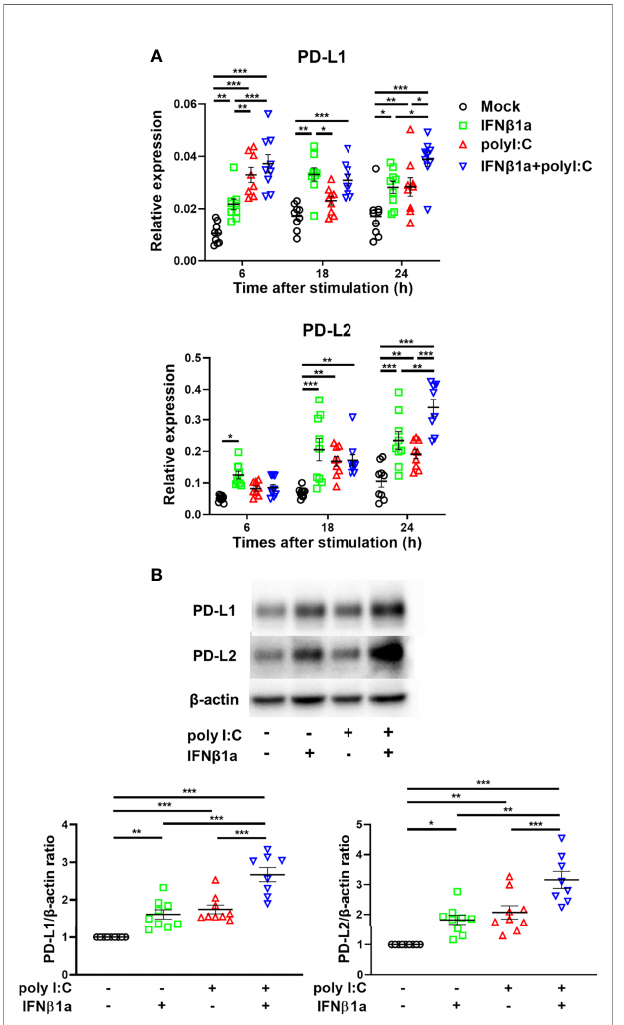
FIGURE 2 | Antiviral interferon induces gene and protein expressions of PD- L1 and PD-L2 in PBECs. PBECs were pretreated with 250 U/ml IFN b 1a or vehicle for 1 h and then stimulated with 1 m g/mL poly I:C. (A) PD-L1 and PD- L2 gene expressions were measured at the indicated times by real-time quantitative reverse-transcription PCR and normalized to that of 18S rRNA. (B) Representative western blots showing PD-L1 and PD-L2 in PBECs 24 h following stimulation. Band intensity was quantitated using densitometry. Data represent means ± SEM (n=9 per group) and were pooled from three independent donors with three replicates. * p <0.05, ** p <0.01, *** p <0.001 by one- o two-way